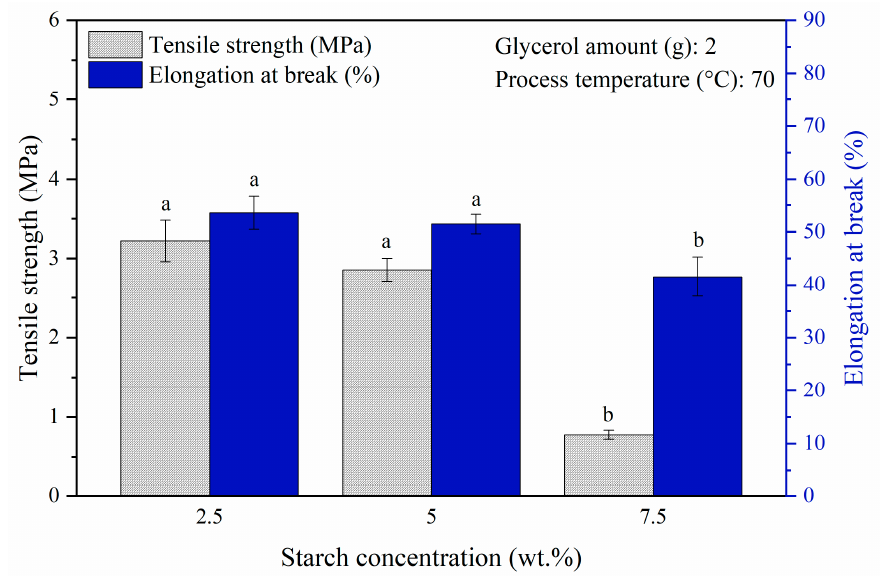
Figure 2. Tensile strength and elongation at break of pure starch-based bioplastic films at different starch concentrations. Different letters indicate the values are significantly different ( p < 0.05). Table 1. Gelatinized duration required and film appearance at different starch concentrations. Starch Concentration (wt.%)